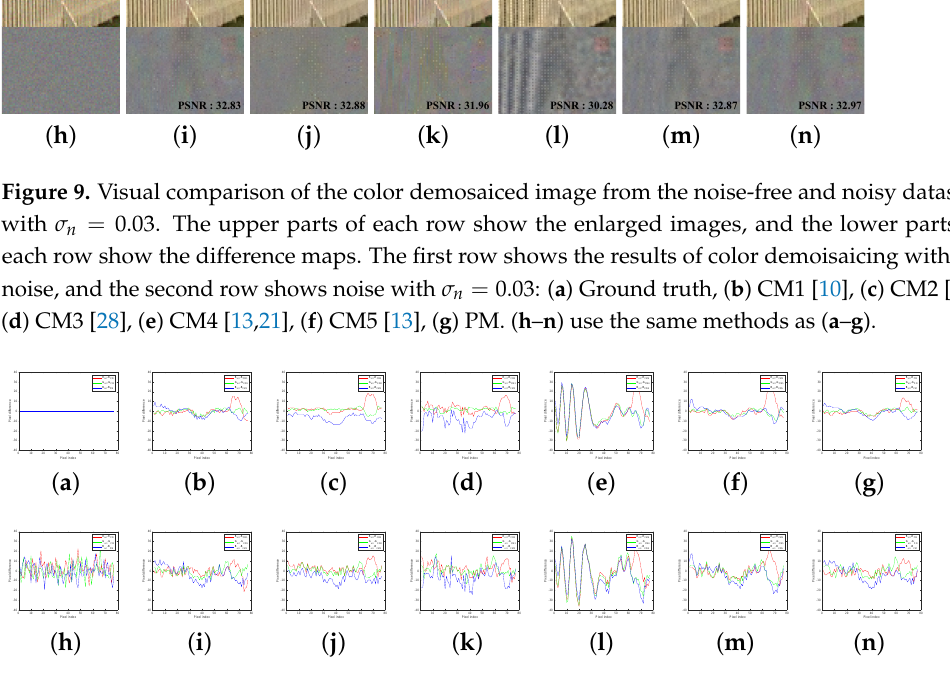
Figure 10. ( a – n ) The difference between original and each method in Figure 9a–n at the red line location in Figure